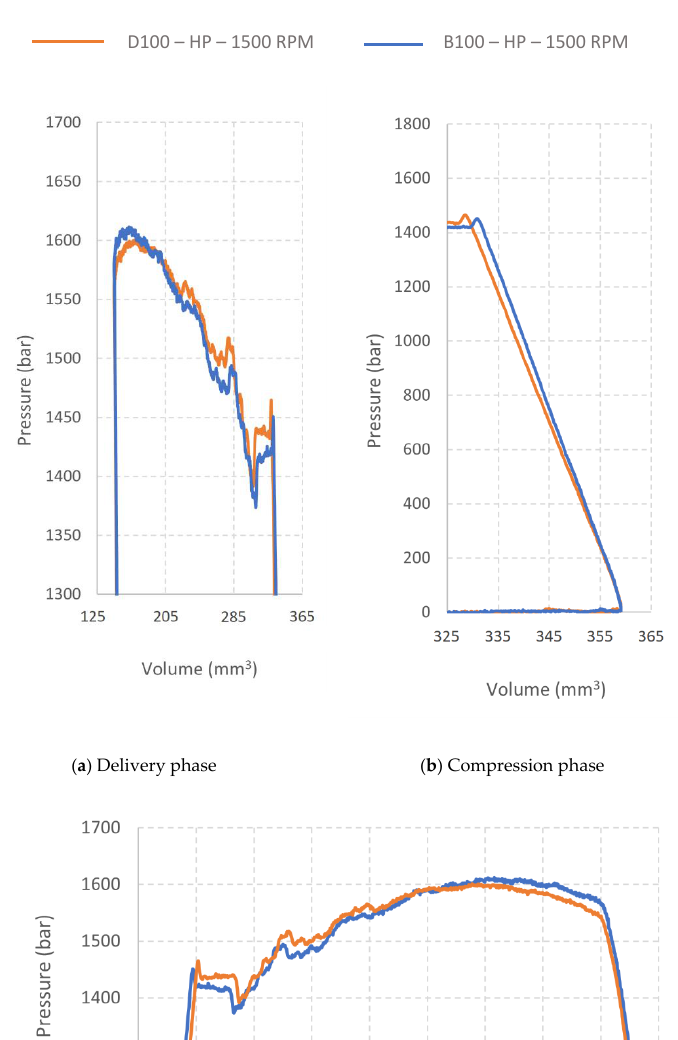
Figure 11. PWC and inlet diagrams for B100 and D100 at 3000 RPM, HP.